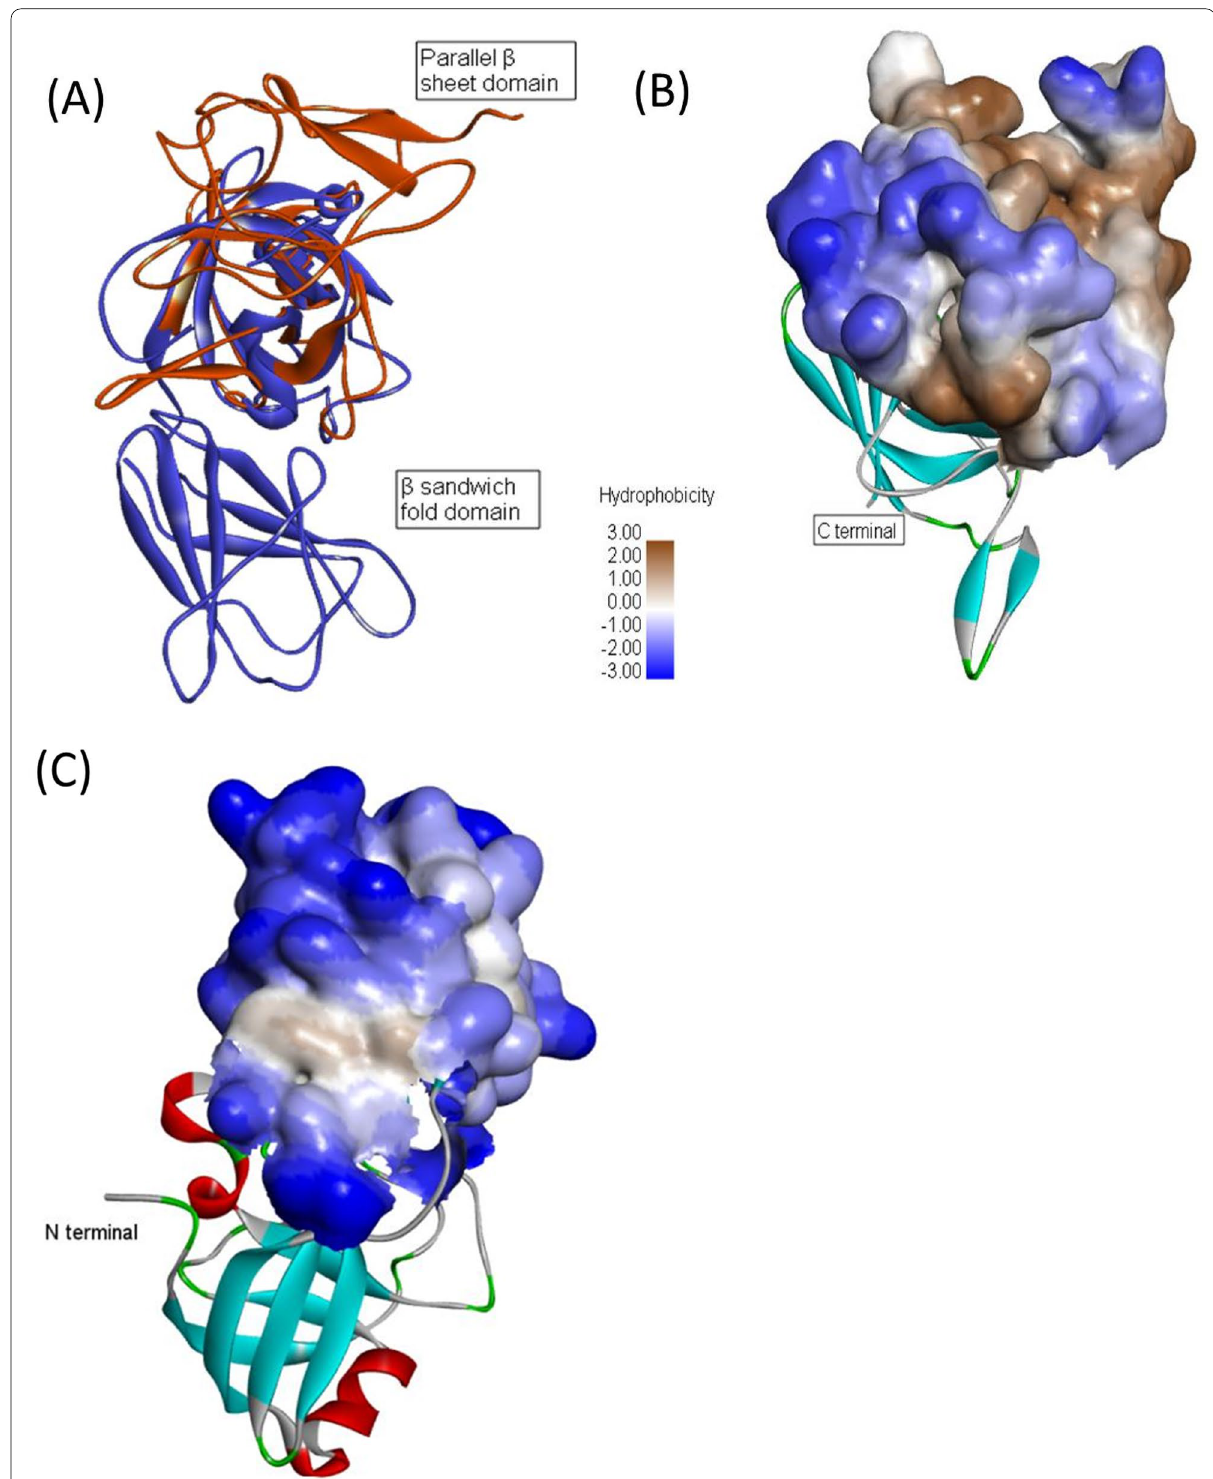
Fig. 2 The predicted structure model of CxEXL22: A overall structures superimposition of the predicted CxEXL22 modeling (orange) and BsExl (PDB:3D30, blue); B the hydrophobic groove surface of parallel β sheet domain; C the hydrophobic surface of